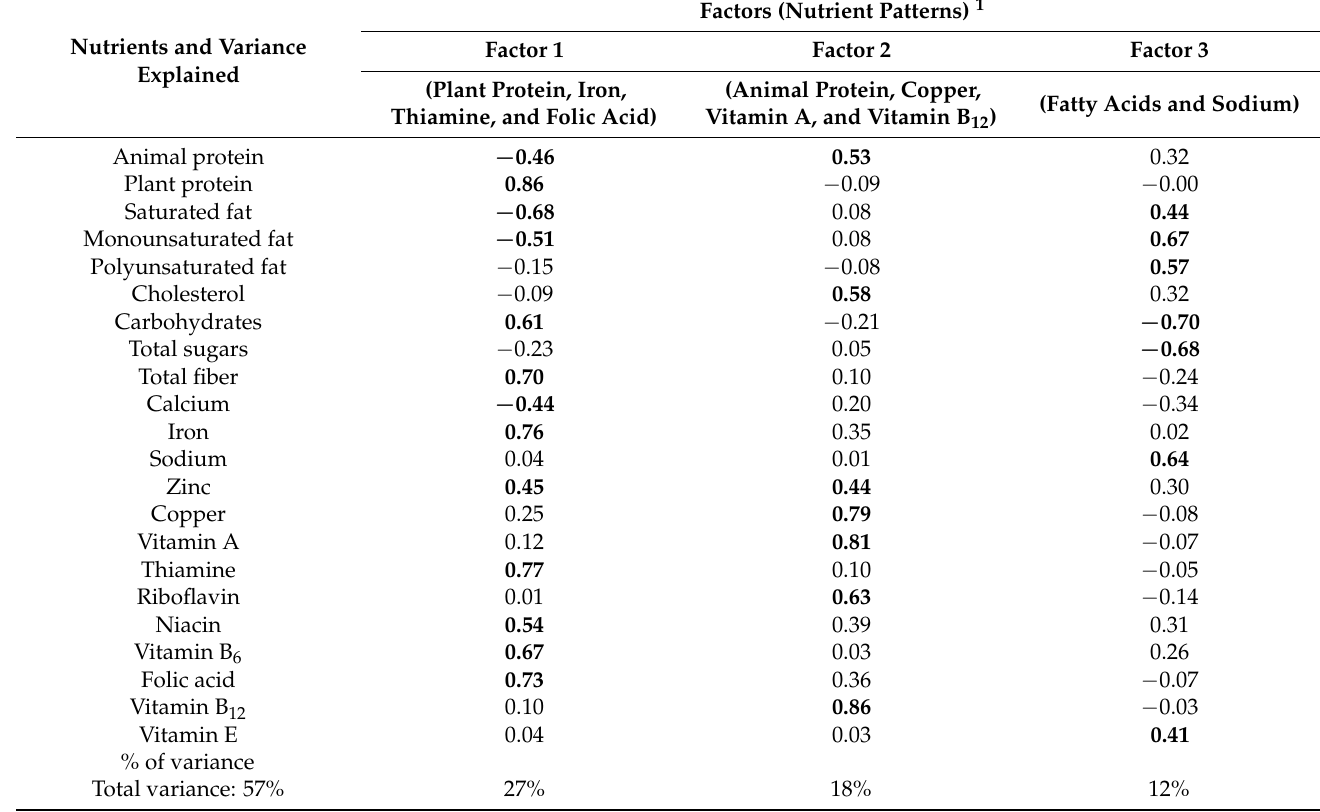
Table 4. Nutrient patterns and factor loadings extracted using factor analysis during early pregnancy ( n =